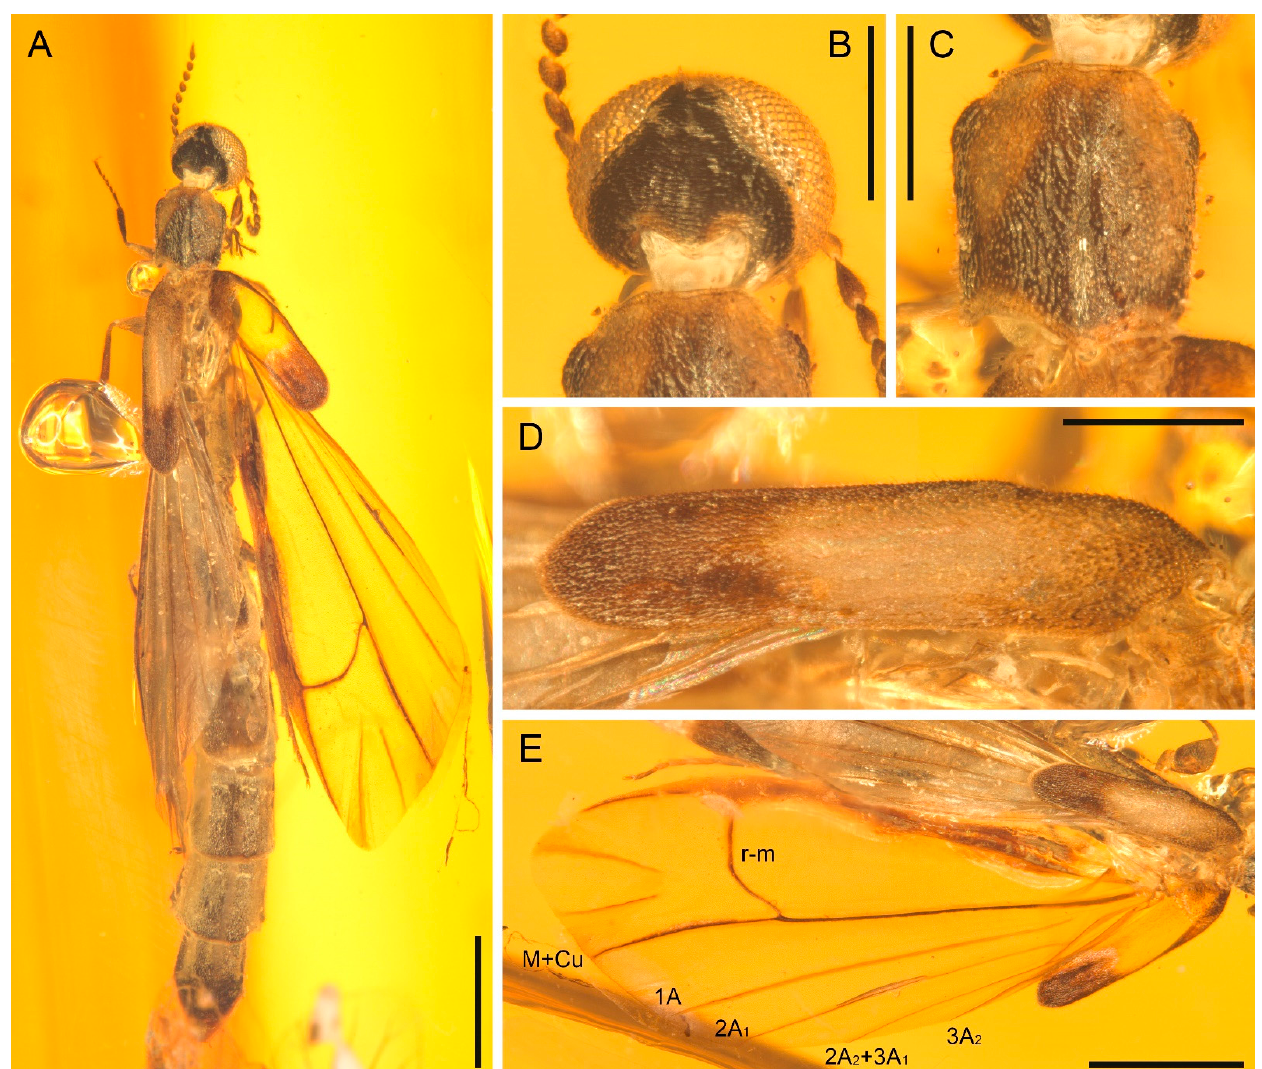
Figure 3. Cretoquadratus fossilis (Yamamoto) comb. nov. , NIGP180658, under incident light. ( A ) Habitus, dorsal view. ( B ) Head, dorsal view. ( C ) Prothorax, dorsal view. ( D ) Elytron, dorsal view. ( E ) Right hind wing. Scale bars: 1 mm in ( A , E ), 400 μ m in ( B – D ).